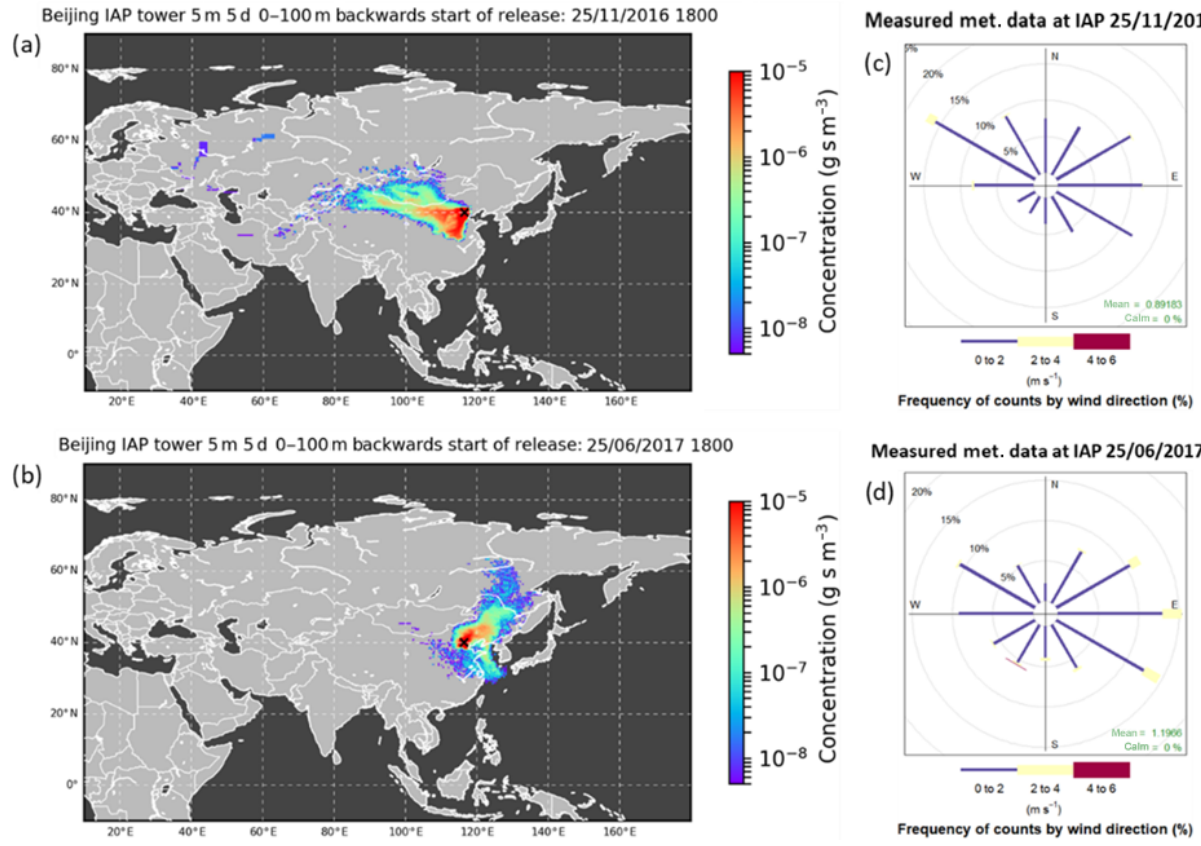
Figure 6. Example footprints of air masses arriving in Beijing from the south (a) and north (b) and wind data measured at the ground level during these days (c, d)